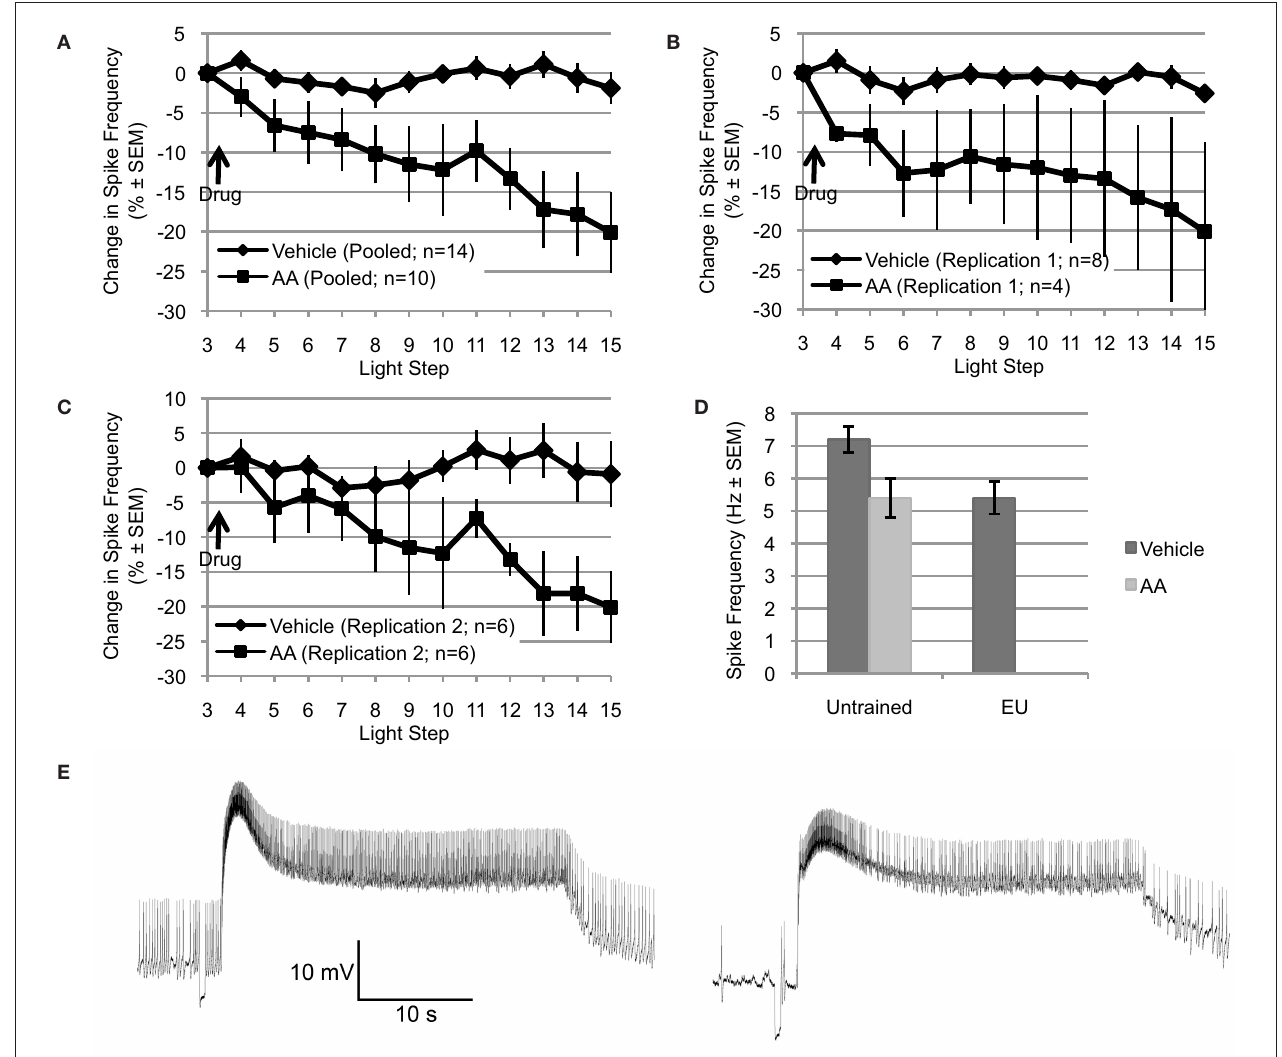
reduction produced by EU training. During the 15th light step, Type B FigurE 1 | Arachidonic acid mimics the reduction in spike frequency photoreceptors from untrained Hermissenda spiked at 7.2 Hz; however, when observed following Eu training. ( A through C ) Applied after the 3rd light step, treated with AA, Type B photoreceptors from untrained Hermissenda spiked at AA (10 − 4 M) reduced light-evoked spiking over the remaining 12 light steps 5.4 Hz. In comparison, after EU training, Type B photoreceptors spiked at 5.4 Hz. ( ∼ 22–24 min). In contrast, the spike frequency of Type B photoreceptors In A through D , as well as in all subsequent figures for which summary data are exposed to vehicle (dH O + 0.1% ethanol) was essentially unchanged over the 2 presented, each data point represents a mean ± SEM. (E) Representative light same period. Changes in spike frequency are expressed as percent change response from a Type B photoreceptor treated with AA: 3rd light step (left) and relative to that observed during the third light step, just prior to AA or vehicle 15th light step (right). Note the reduction in spike frequency, which was 41% for addition. (A) Shows pooled data from two independent replications (shown in this cell (during the last 10 s of the light B and C ). (D) The reduction in spike frequency produced by AA mimicked the